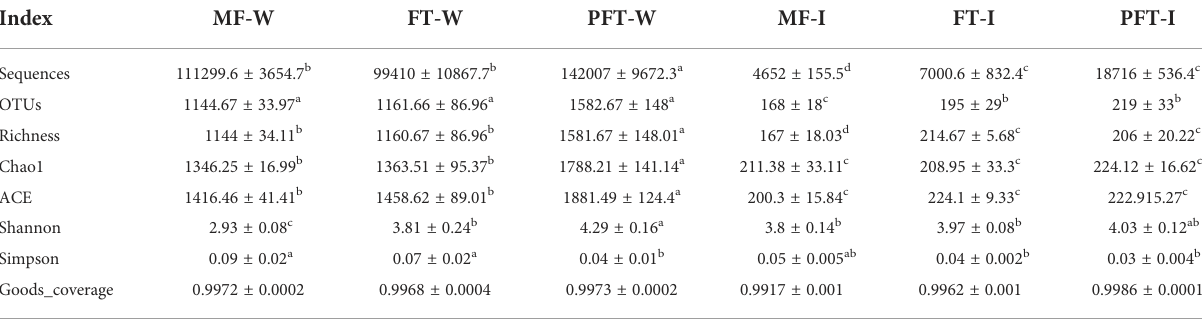
TABLE 1 Diversity indices and OTU richness for the intestinal bacterial diversity analysis of S. pharaonis during the feed